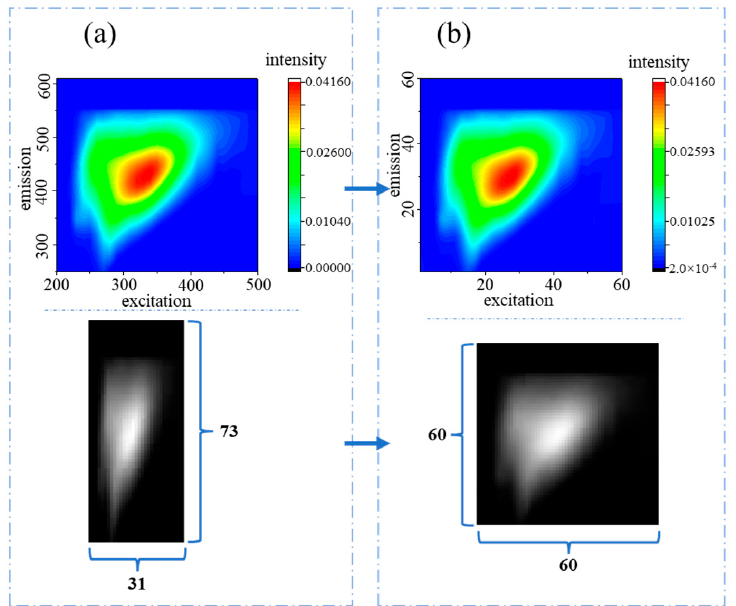
Figure 5. Comparison before and after 3D-EEMs interpolation. ( a ) Before interpolation; and ( b ) After interpolation. In ( b ), emission and excitation from 1 to 60 represent the number of wavelengths and excitation wavelengths, and the range of wavelengths is still consistent with that in ( a ).